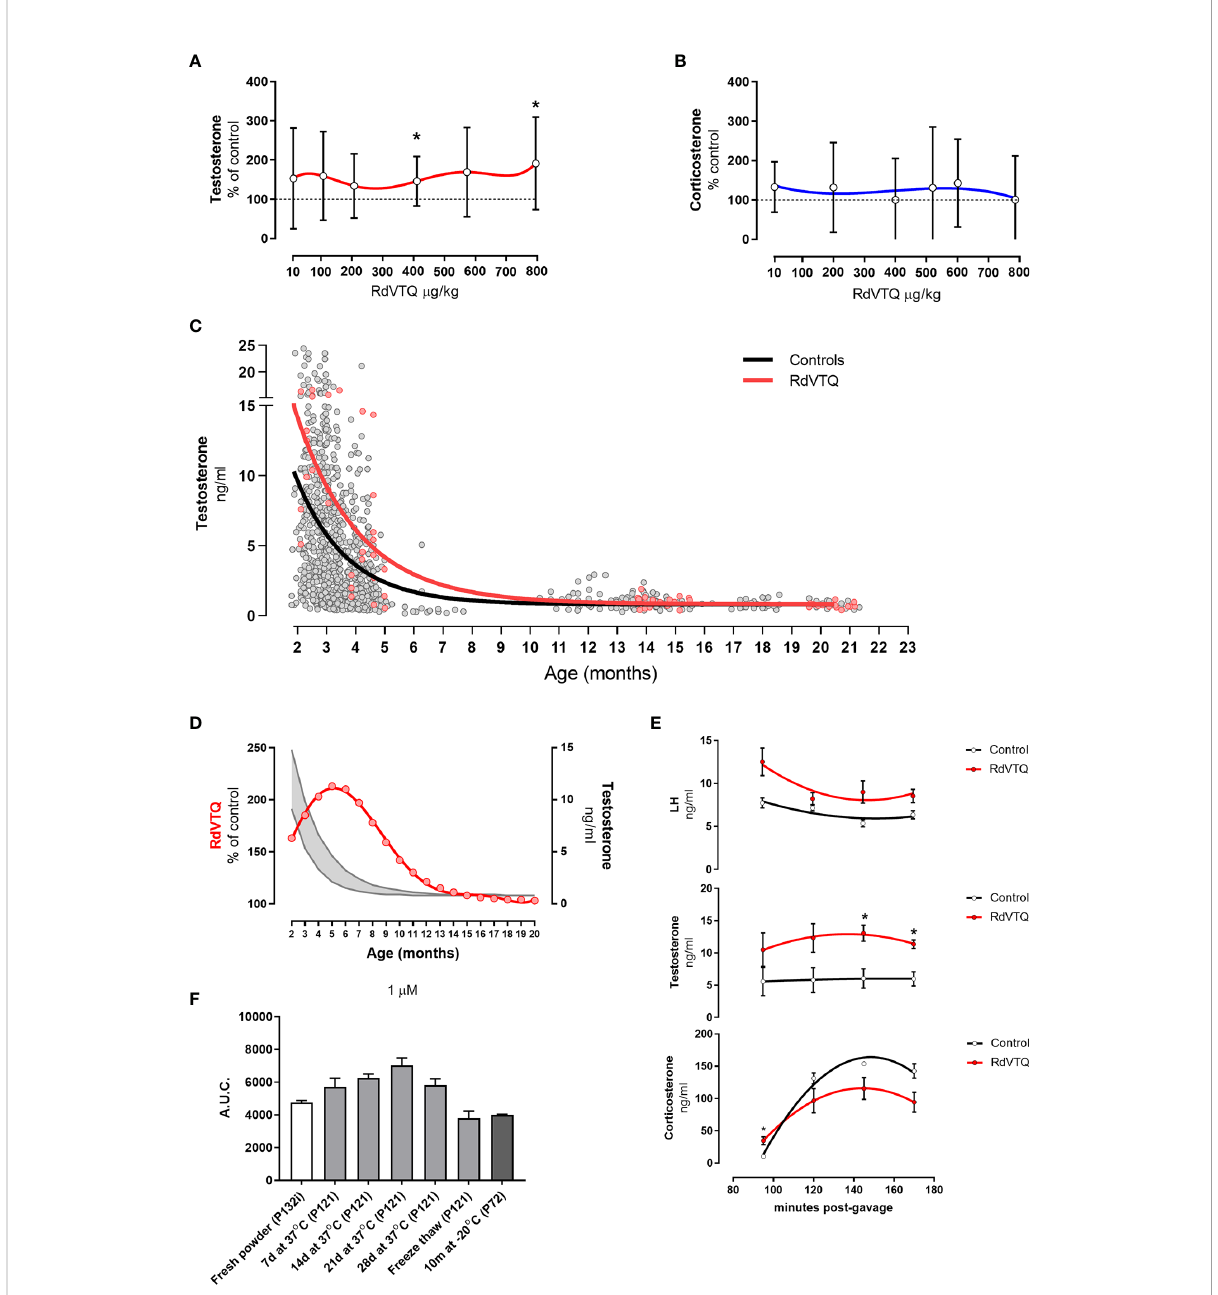
FIGURE 5 (A-B) Dose response shows biphasic response in some peptides. (A) Testosterone and (B) corticosterone levels of Brown-Norway rats 2 hrs after gavage with the various concentrations of RdVTQ. Age of Brown-Norway rats during experiment was 88-138 days-old; N = 8; results shown as mean ± SD; *p<0.05. (C) Circulating testosterone levels in Brown-Norway rats under various conditions and ages. Testosterone levels in rats gavaged with water (control; black line) or 550 m g RdVTQ/kg (red line). Plasma samples were collected 2hrs post-gavage. Plasma samples were collected 90 min post-intraperitoneal injection. The lines represent the equation that best- fi ts the data collected. Each dot represents the average of two measurements per sample. Control (black line) includes 897 dots and RdVTQ (red line) includes 62 dots. (D) Effect of RdVTQ on circulating testosterone levels throughout the lifetime. Grey lines represent the average testosterone levels of rats gavaged with control (water; grey lower line) or RdVTQ (550 m g/kg; grey upper line). Red line represents the projected RdVTQ-driven percent testosterone level increase throughout the rat lifetime. These data were calculated from the best- fi t analysis. (E) Effect of RdVTQ on circulating LH, testosterone, and corticosterone levels in selected timepoints after gavage. Sprague-Dawley rats were gavaged with 550 m g RdVTQ/kg (0 minutes) followed by jugular plasma collection at the denoted time points. N = 4; results shown as mean ± SEM; *p<0.05. (F) Stability of RdVTQ under various conditions. RdVTQ was maintained at 37°C for the denoted timepoints, submitted to three cycles of freeze thaw, or stored for 10 months at -20°C. Stability of each condition was ascertained by mass-spec quanti fi cation. Area under the curve (AUC) was plotted for each